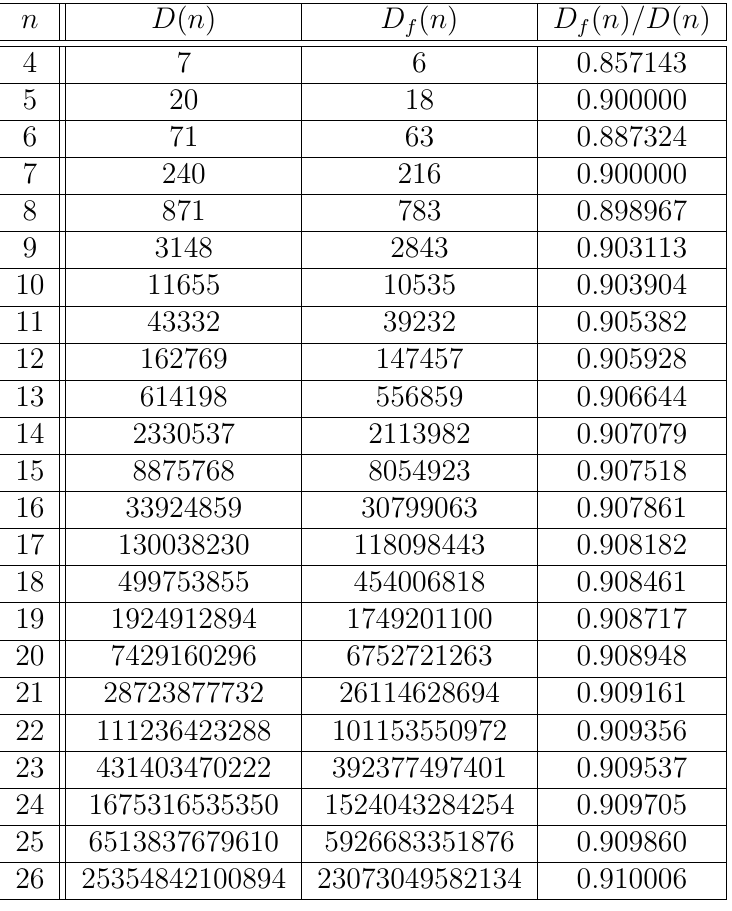
Table 4: Number of forcibly connected graphical degree sequences of length n and their proportions in zero-free graphical degree sequences of length n